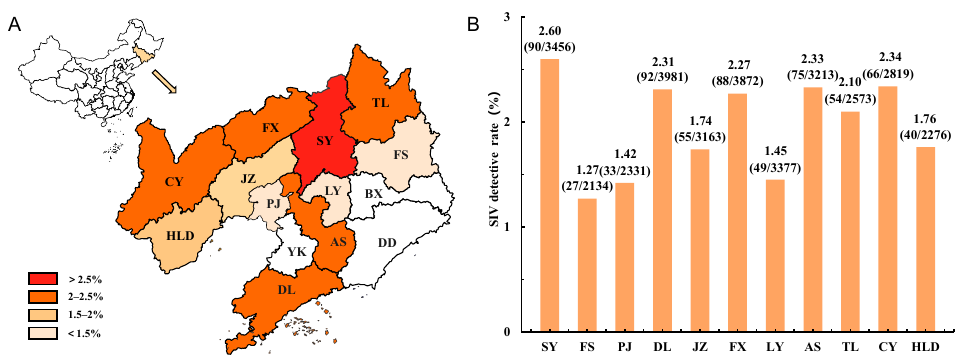
Figure 1. Detective of swine influenza virus (SIV) in Liaoning province. ( A ) Geographical distribution of sampling cities in Liaoning in 2020. The red color represents the isolation rate (%) of each city. ( B ) SIV detection rates in each city of Liaoning. SY, Shenyang; FS, Fushun; PJ, Panjin; DL, Dalian; JZ, Jinzhou; FX, Fuxin; LY, Liaoyang; AS, Anshan; TL, Tieling; CY, Chaoyang; HLD, Huludao.